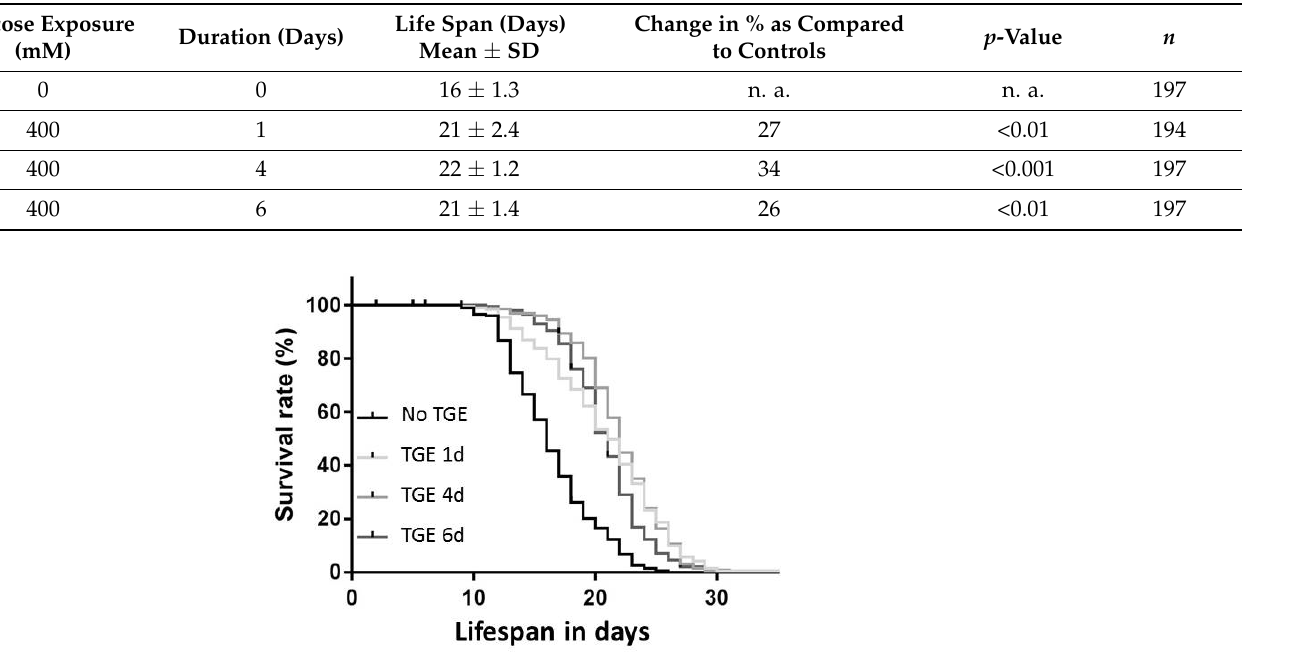
Table 1. Lifespan of C. elegans after TGE of one, four, and six days.